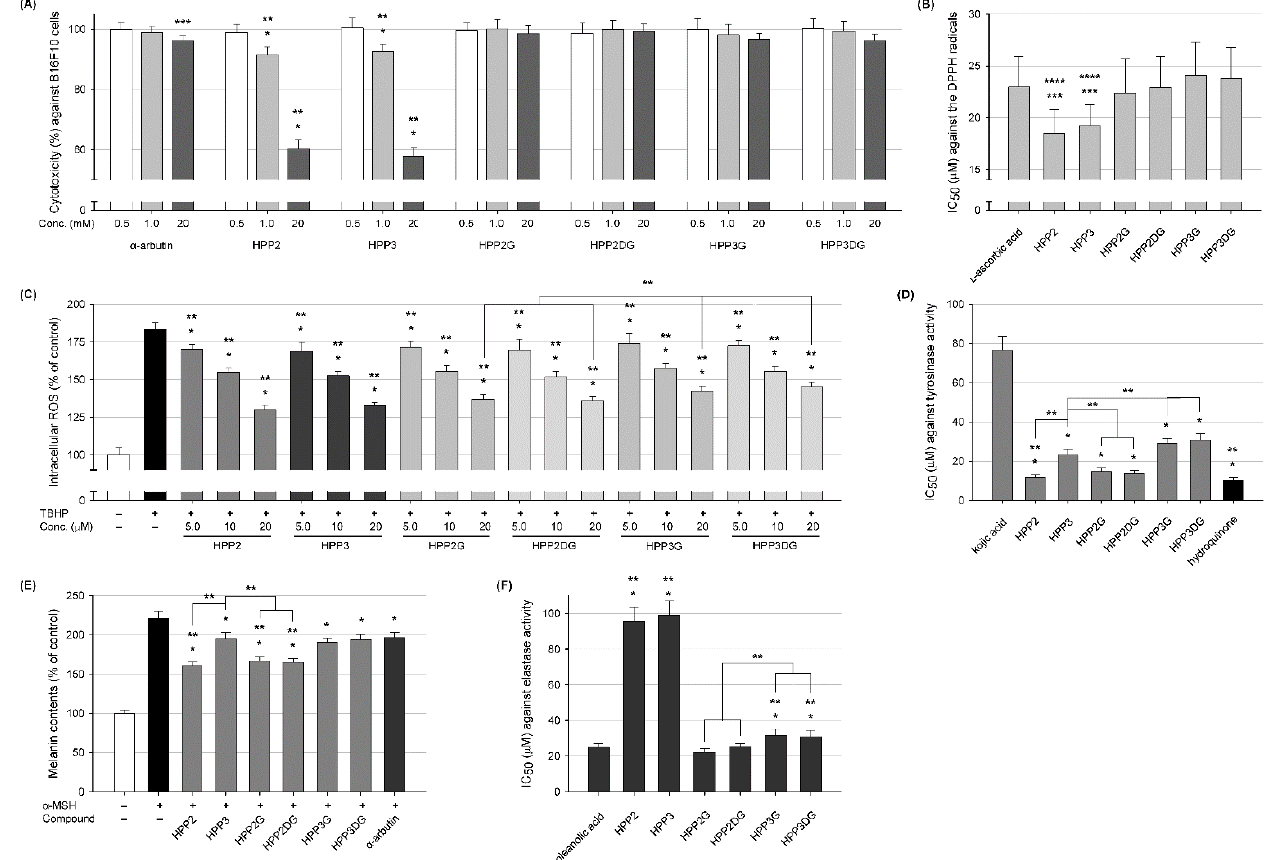
Figure 4. Biological activities of SP aglycones and their glycosides. ( A ) cytotoxicity against B16F10 murine melanoma cells (α -arbutin as a reference), ( B ) in vitro DPPH radical scavenging antioxidant activity represented as IC 50 values ( L -ascorbic acid as a positive control), ( C ) in vivo ROS scavenging antioxidant activity against tert -butyl hydroperoxide (TBHP)-induced B16F10 cells, ( D ) in vitro tyrosinase inhibitory activity represented as IC 50 values (kojic acid as a positive control, and hydro- quinone as a comparative one), ( E ) inhibitory activity against the intracellular melanin biosynthesis in B16F10 cells (α -arbutin as a positive control) at fixed 20 μ M treatments, and ( F ) in vitro elastase inhibitory activity (oleanolic acid as a positive control). HPP2: hydroxyphenyl-2-propanol; HPP3: hydroxyphenyl-3-propanol; HPP2G: hydroxyphenyl-2-propanoyl- O - α -glucoside; HPP2DG: hy- droxyphenyl-2-propanoyl- O - α - 2″ -deoxyglucoside; HPP3G: hydroxyphenyl-3-propanoyl- O - α -glu- coside; HPP3DG: hydroxyphenyl-3-propanoyl- O - α - 2″ -deoxyglucoside. Results (* p < 0.01 vs. con- trol; ** p < 0.01 vs. treatments; *** p < 0.05 vs. control; **** p < 0.05 vs. treatments) were considered significant.